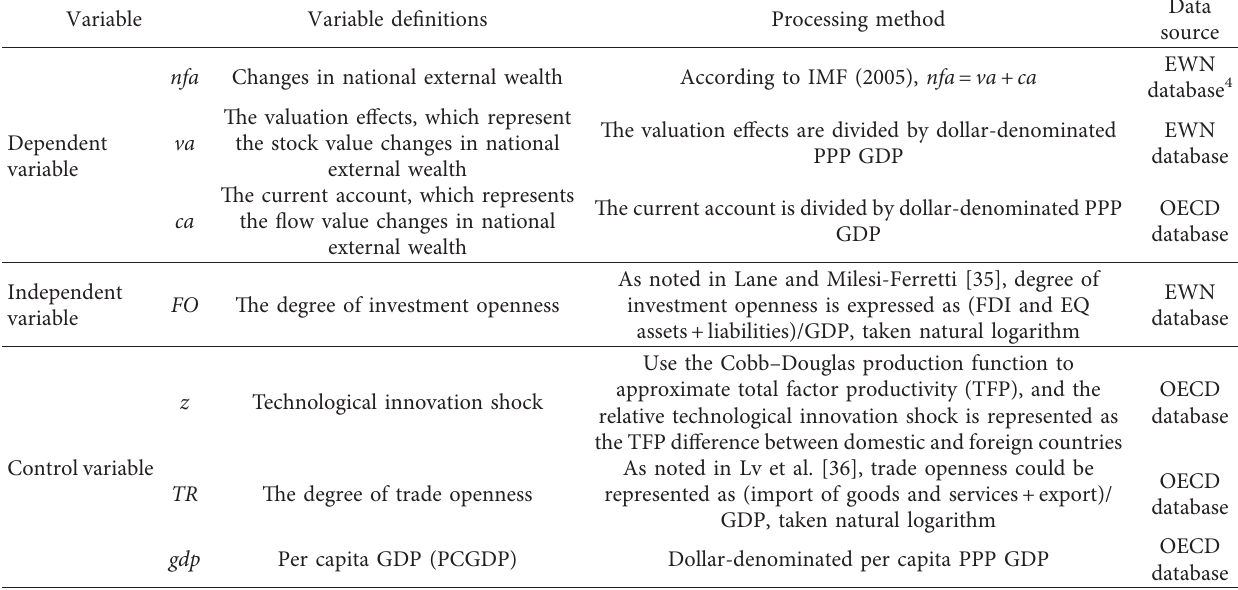
Table 1: Empirical variable processing methods and data sources.